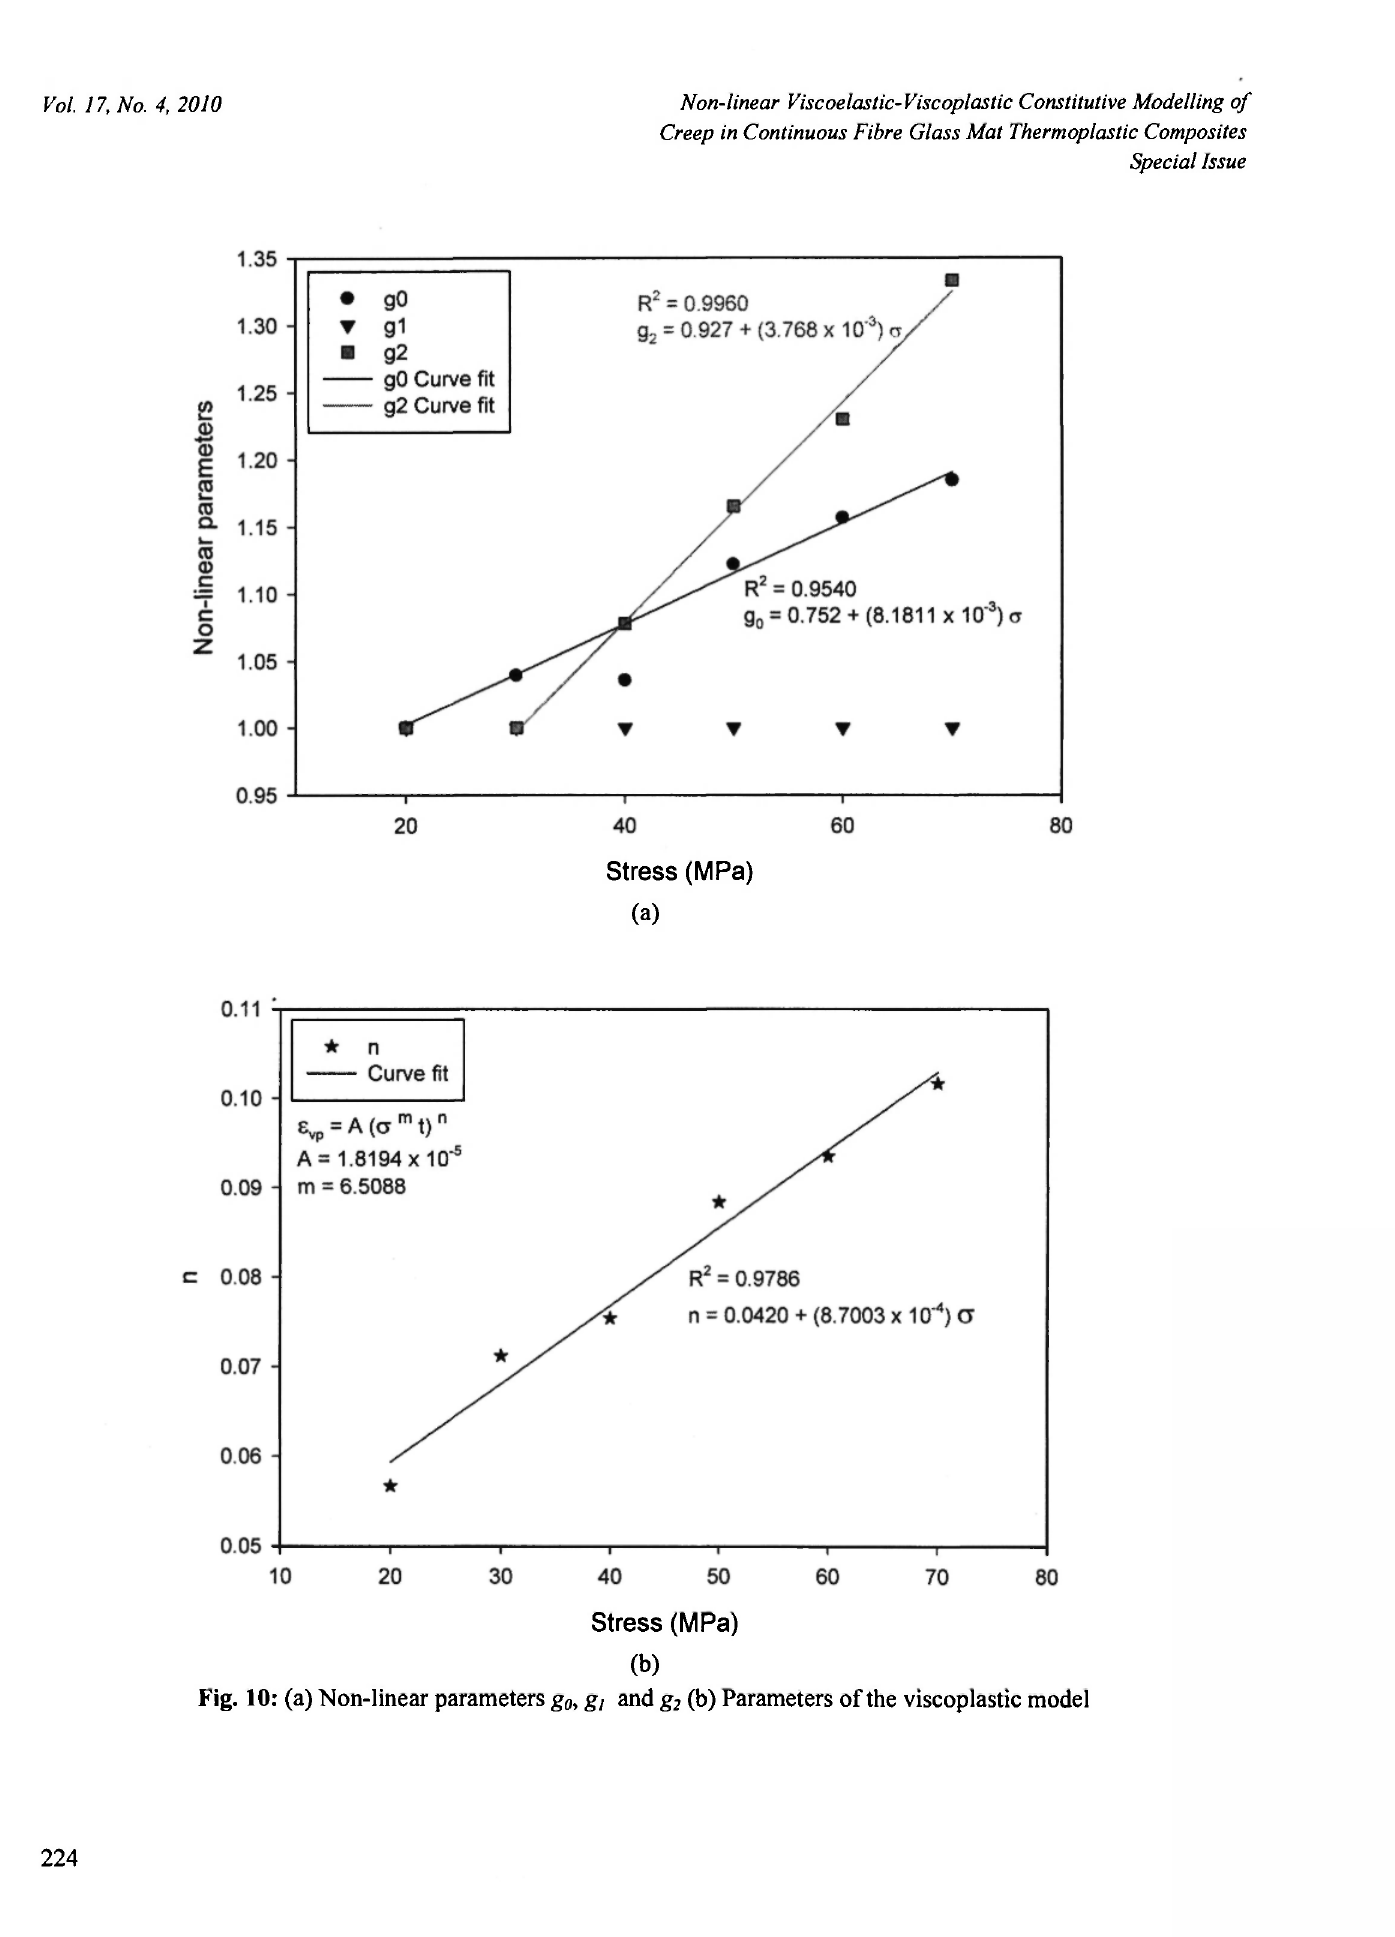
Fig. 10: (a) Non-linear parameters g 0 , gi and g 2 (b) Parameters of the viscoplastic